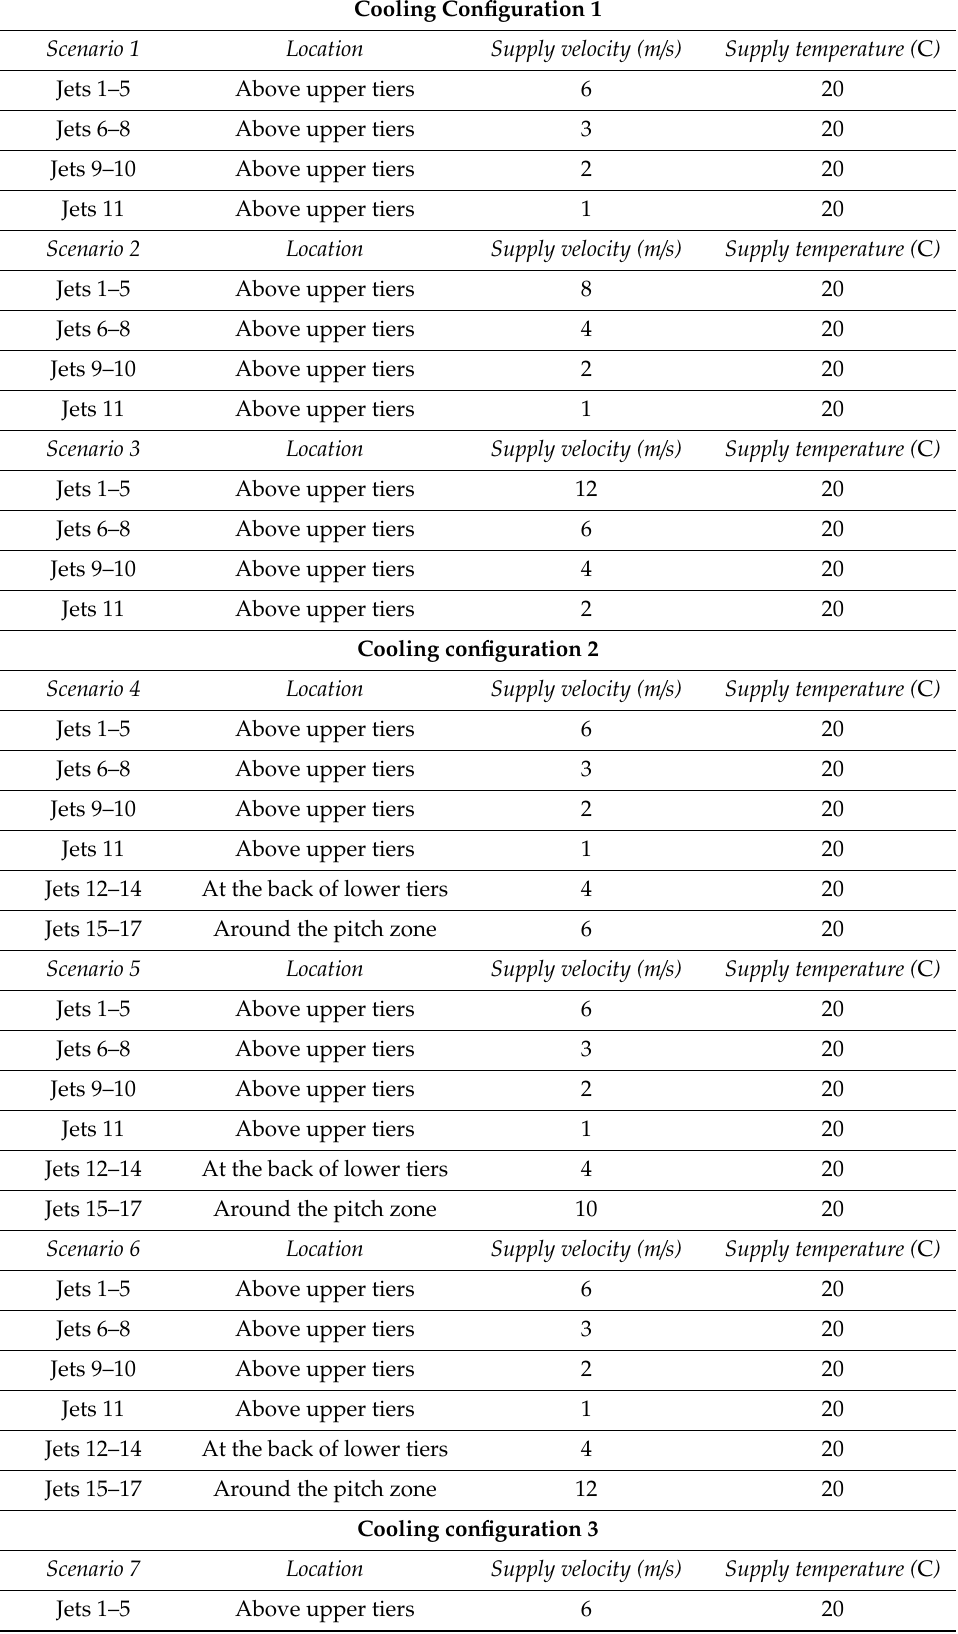
Table 3. Cooling scenarios under each cooling